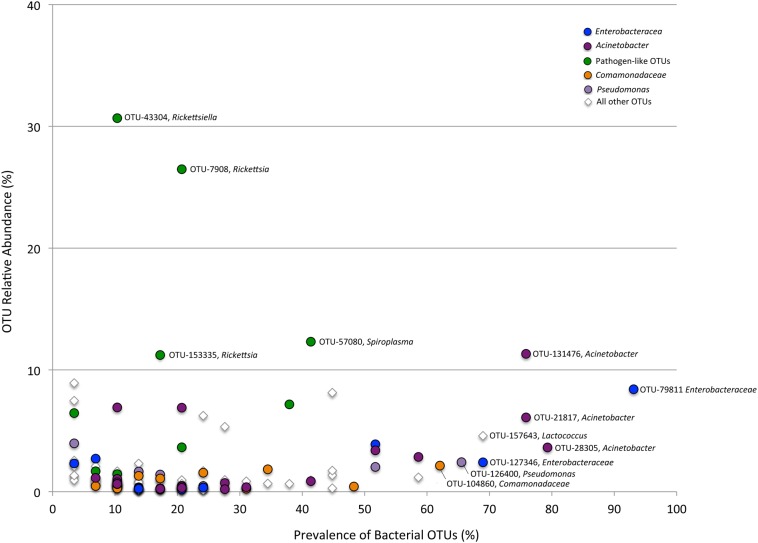
Prevalence versus relative abundance of bacterial OTUs.Prevalence versus relative abundance of bacterial OTUs associated with six Cephaloleia species (n = 29 specimens, collected on native diets). Certain dominant OTU groups are indicated separately by color (e.g., Acinetobacter), with 12 shown by OTU# based on ≥60% prevalence or ≥10% relative abundance (including four noted in green that matched bacterial groups typically thought of as pathogens).